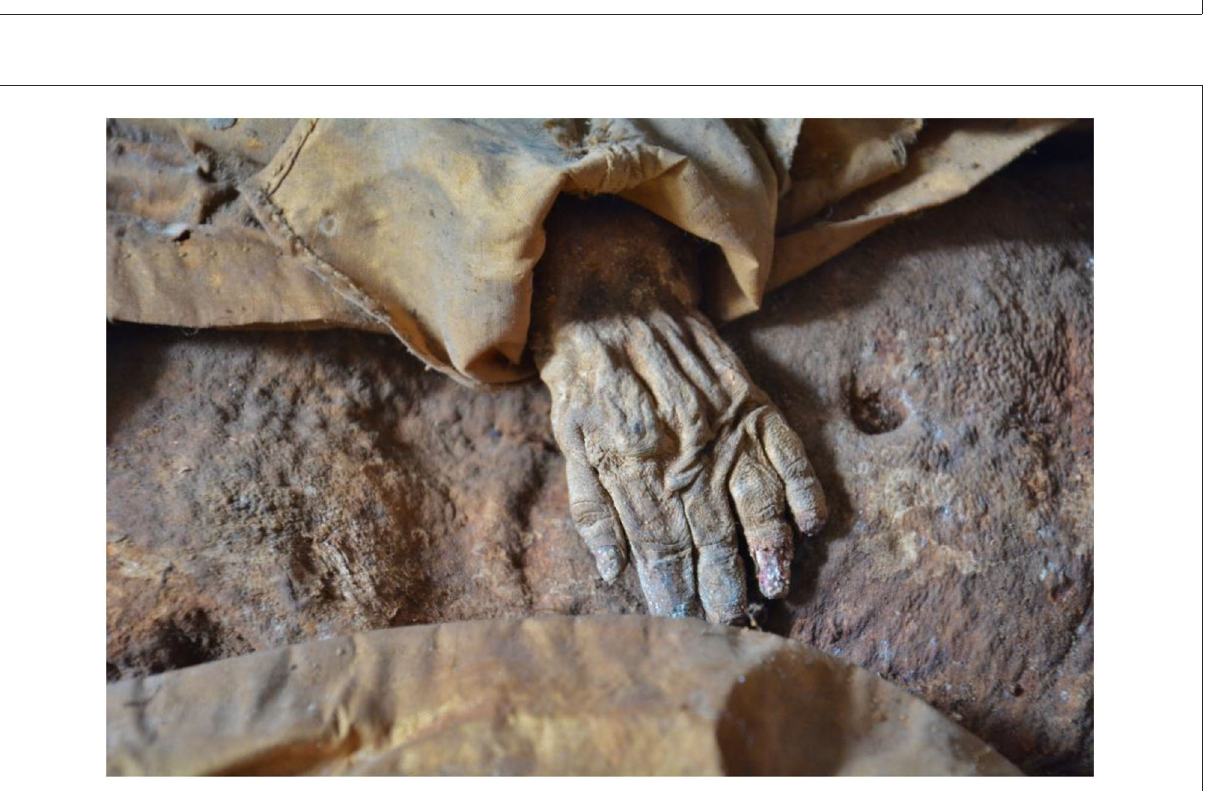
FIGURE2 Detail of the mummy: left hand on the abdomen. Note also the retracted navel.